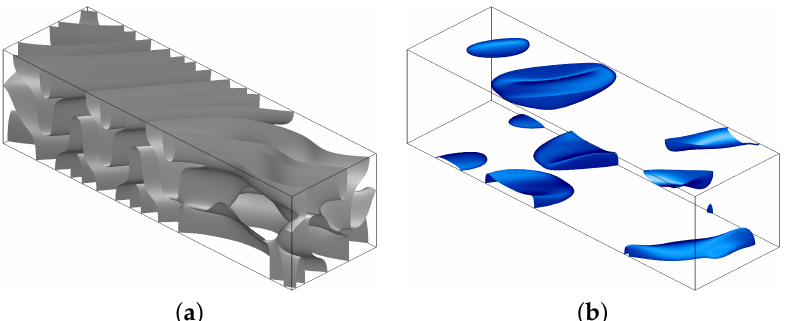
Figure 24. Isosurfaces of the kinetic (a) and magnetic (b) energy densities at the levels of 50% and 35% of their respective maxima in run 4 x 1.1 at time t = 222.626. One quadruple-period fluid box is shown.